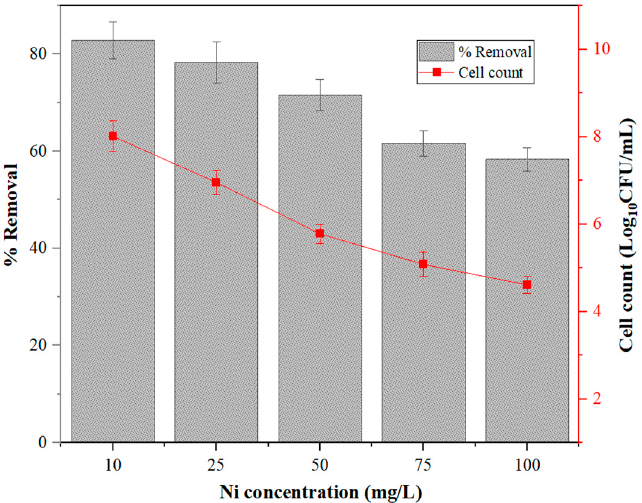
Figure 8. Effect of initial Ni 2+ concentration on removal efficiency of PSDB.